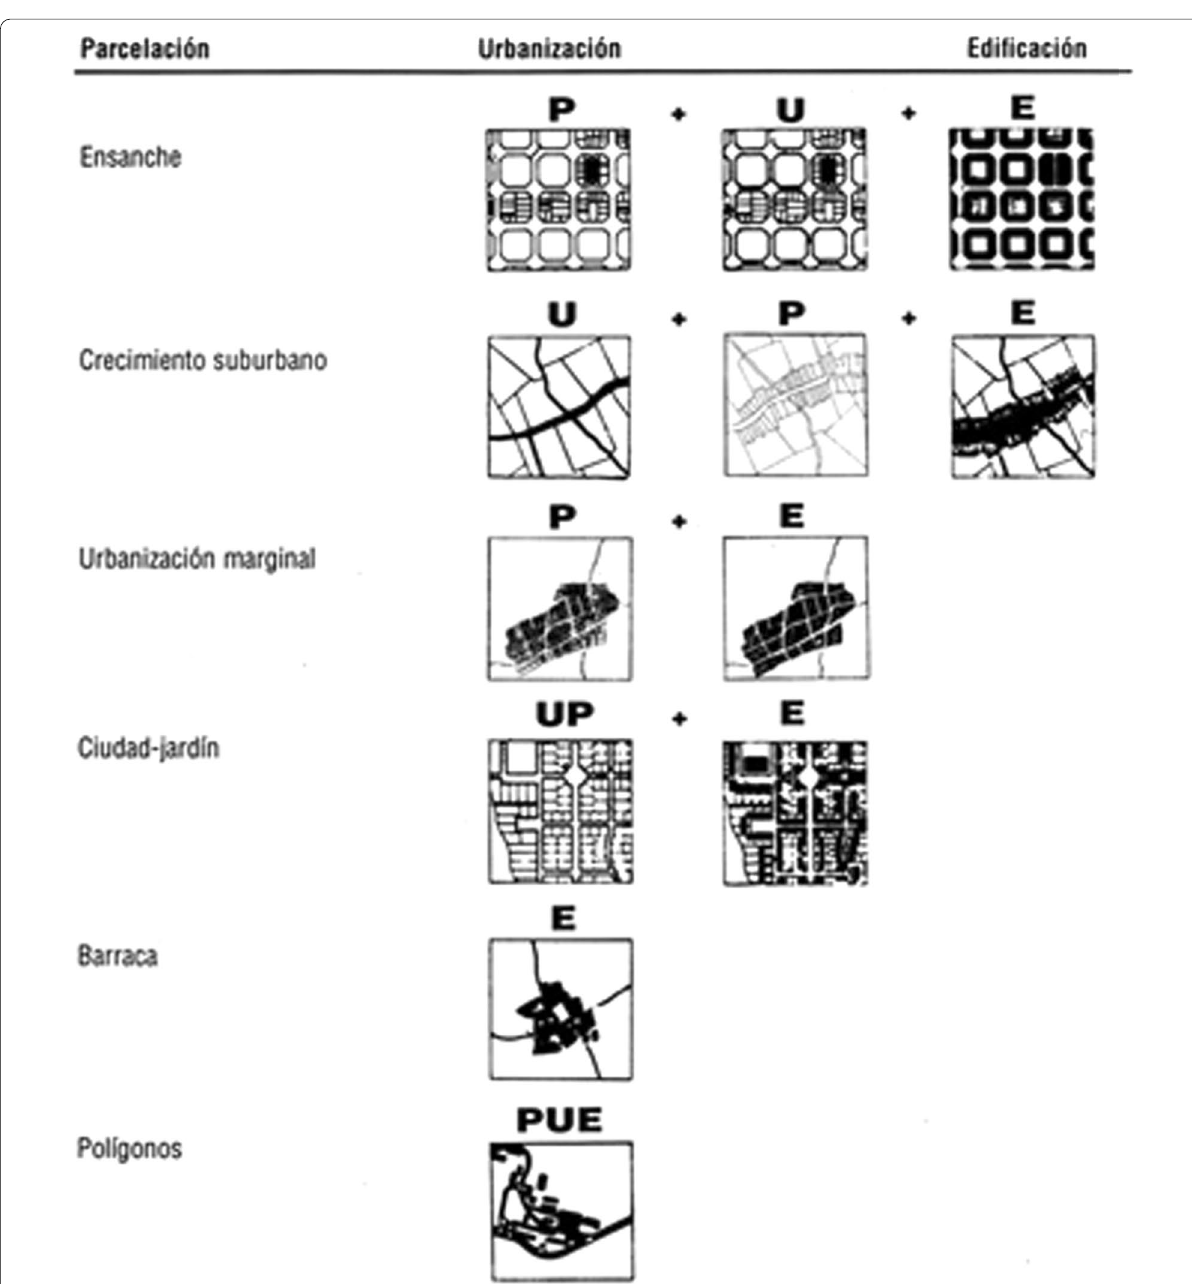
Fig. 2 Solà-Morales. ‘Las formas de crecimiento urbano’. PUE combinations. 1973. Source: Solà-Morales M (1973 [1997]) Las Formas de Crecimiento Urbano. Barcelona: